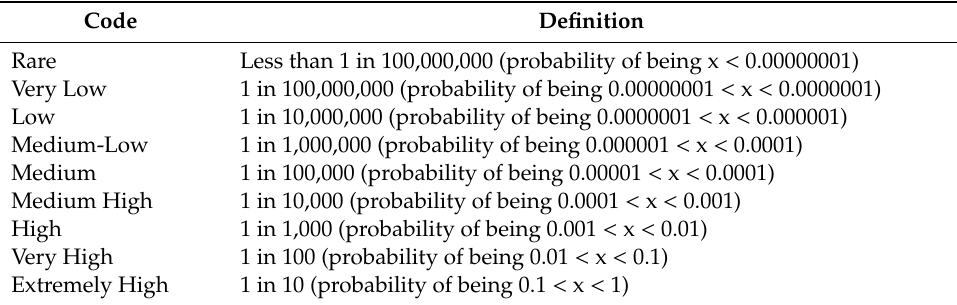
Table 5. Occurrence / Frequency Scale (Adapted from [85]).